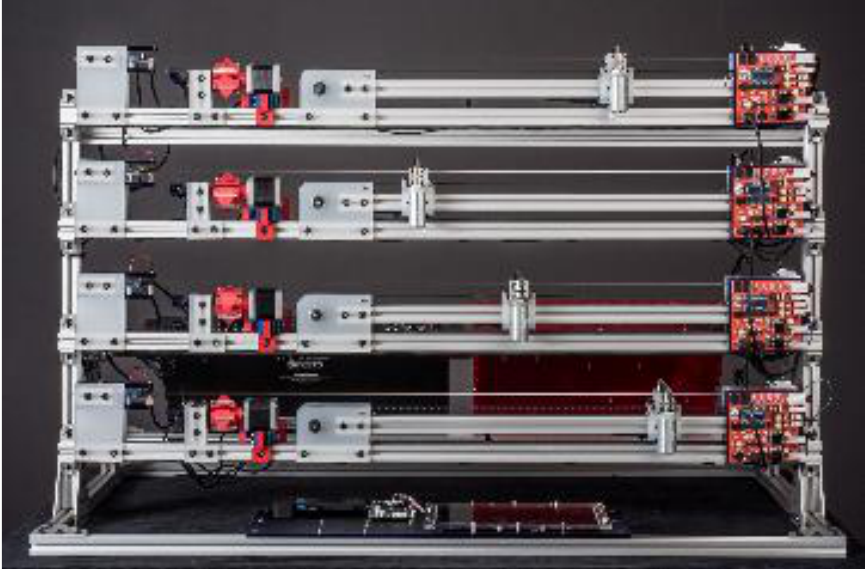
Fig. 1. MechBass – a four string robotic